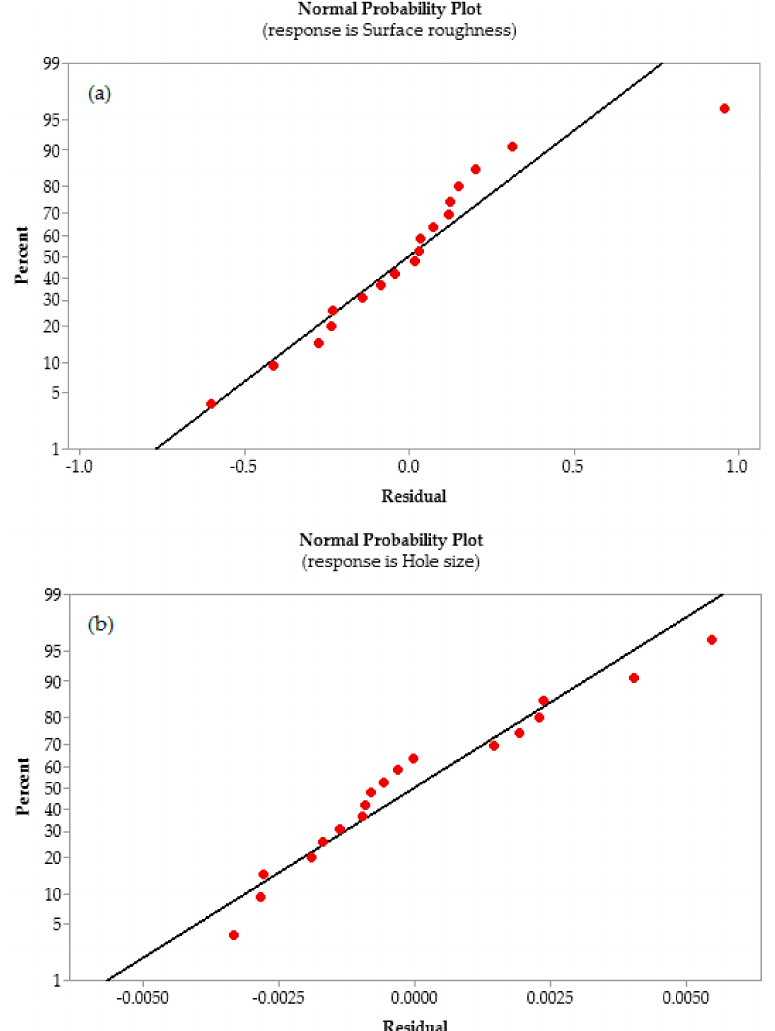
Figure 3. Normal probability plots of residuals for ( a ) surface roughness and ( b ) hole